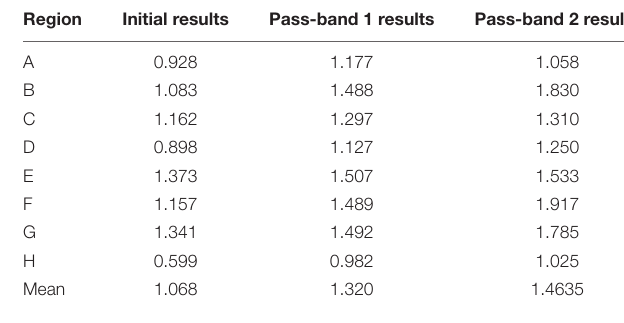
TABLE 5 | Density contrasts derived with TLS by adding a filtering processing (unit: g / cm 3